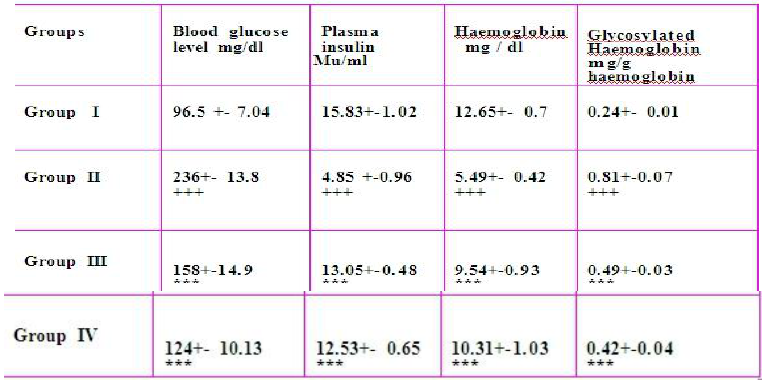
Table-1: Changes in blood glucose, plasma insulin, haemoglobin and glycosylated Haemoglobin levels of control and experimental animals.